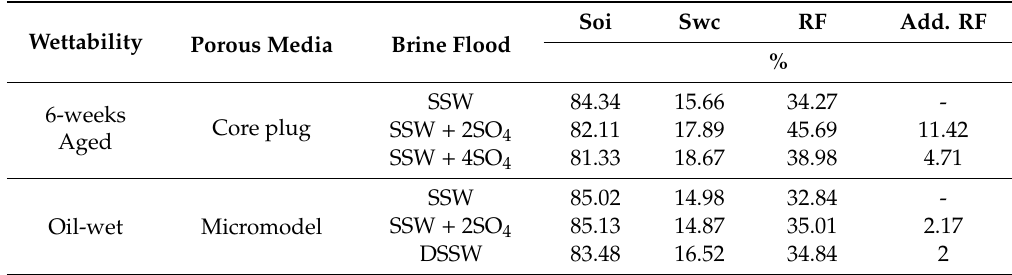
Figure 8. Oil recovery factors of secondary mode brines flood through oil-wet core plugs and micromodels. MM represents the oil recovery from micromodel, CF represents the oil recovery from core flood. Diff.CF/ Diff.MM describes the difference in the RF of the brine flood minus the RF through SSW injection. Table 5. Oil-wet cores and micromodels floods with initial fluids saturations and oil recoveries in secondary mode brines